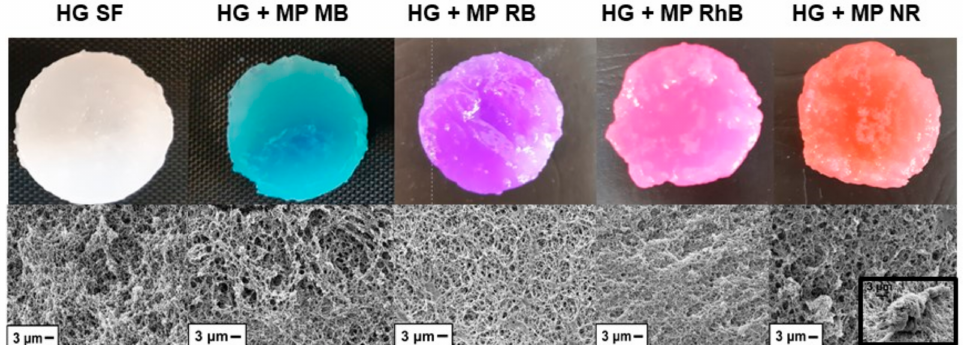
Figure 4. Photographs and scanning electron microscope (SEM) fracture micrographs of SF hydrogels with and without microparticles loaded with